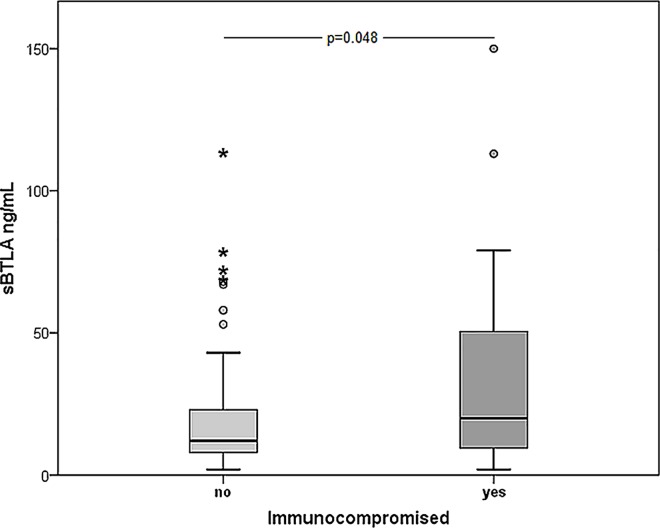
Baseline sBTLA in sepsis patients defined as immunocompromised or not at baseline.Immunocompromised (n = 27) (median 20 ng/mL, IQR, 9–55) or not (n = 71) (median 12 ng/mL, IQR 8–23) (defined by APACHE II criteria at baseline).